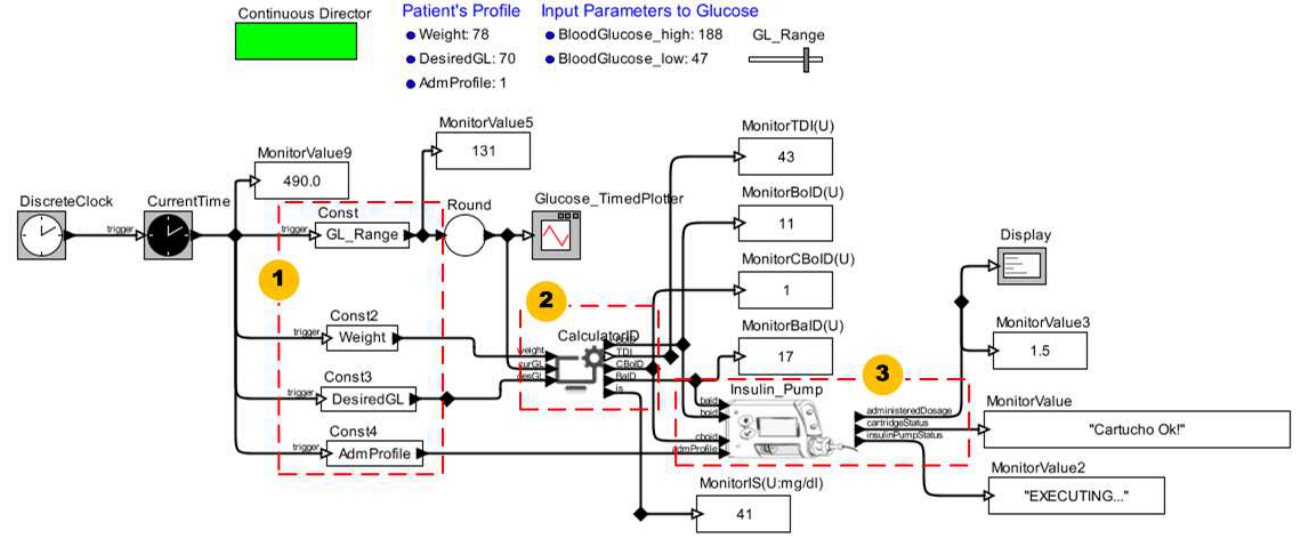
Figure 20. MCPS Model Using the Insulin Pump